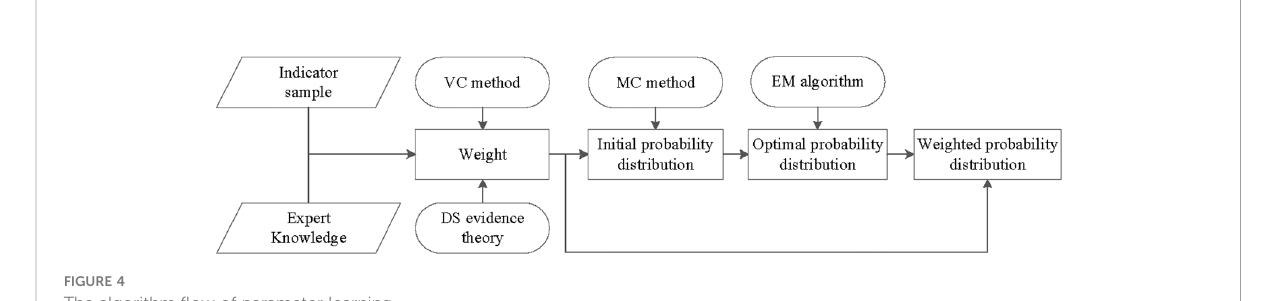
FIGURE 4 The algorithm fl ow of parameter